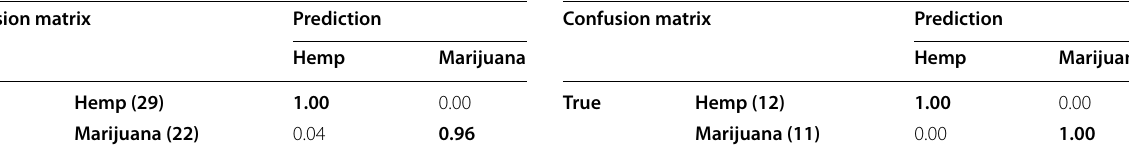
Table 3 Confusion matrix associated with the prediction